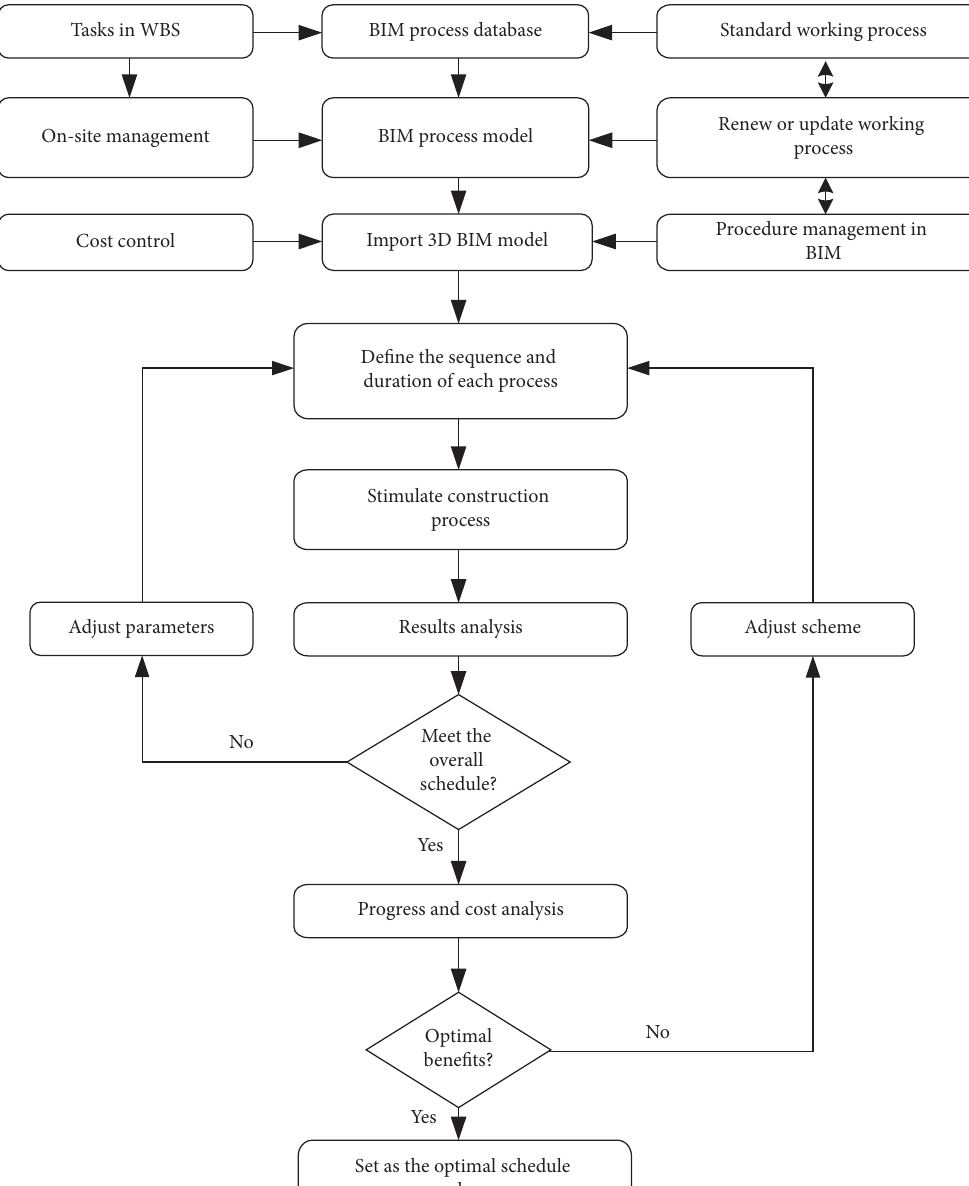
Figure 7: Flow chart of process management